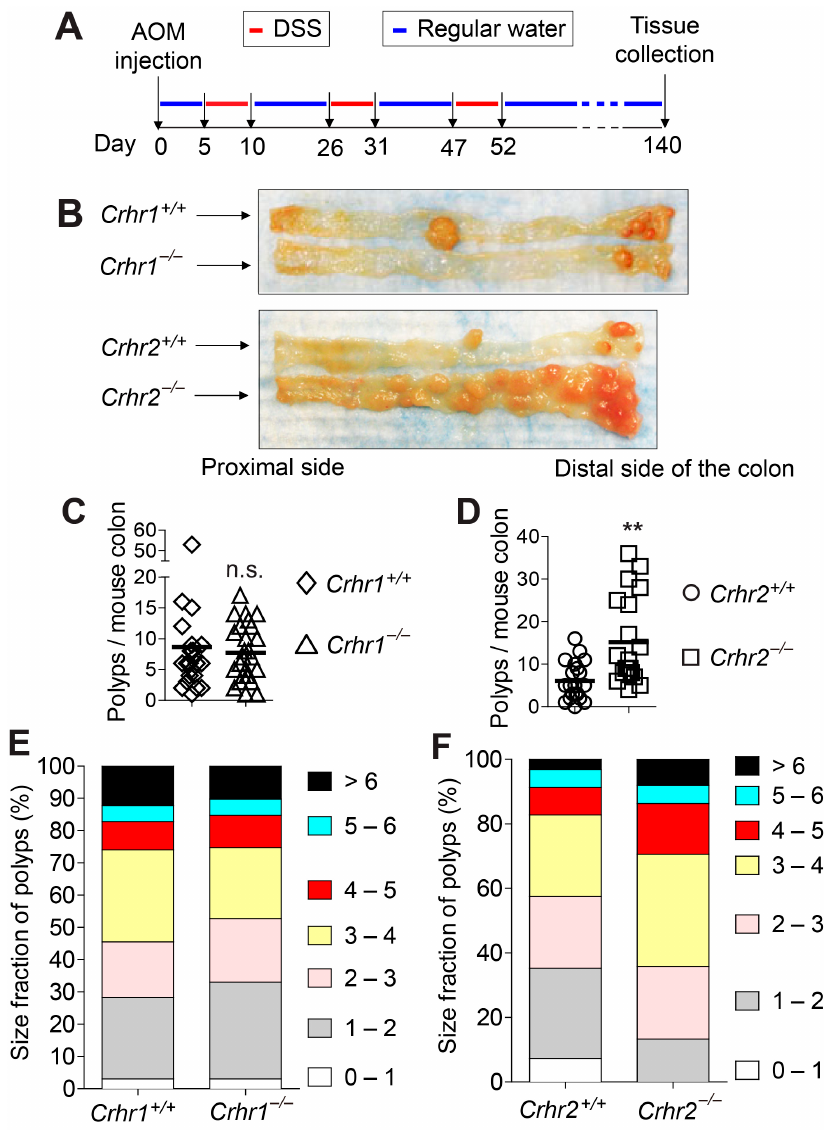
Figure 5. Crhr2 deficiency enhances the tumor development and growth in the azoxymethane (AOM)/dextran sulfate sodium (DSS)-treated mouse model of colon cancer. ( A , B ) Presented is the experimental timeline of the AOM/DSS-treated model of colon cancer. Sex and age matched (5–6 weeks old) mice were intraperitoneally injected with AOM (12.5 mg/kg), followed by the treatment of three cycles of DSS. Then, mice were housed under normal conditions over a total of approximately 140 days before harvesting the tissues. ( B ) Gross images of tumors developed in the colon of mice treated with AOM/DSS. Tumors were mainly developed throughout the mid and distal colon. ( C , D ) We counted the number of visible tumors that were developed in the colon of each mouse. Horizontal bar in each graph indicates mean. ** p < 0.01, n.s. stands for not significant (Mann–Whitney U test). Crhr1 +/+ (n = 22), Crhr1 − / − (n = 26), Crhr2 +/+ (n = 20), and Crhr2 − / − (n = 20). ( E , F ) Tumors developed in the colon were enumerated to analyze relative proportions (%) of tumor size. Tumors were classified based on the tumor size: small (<2 mm diameter), medium-sized (2–4 mm), or large (>4 mm). Presented are the accumulated data from three independent experiments.